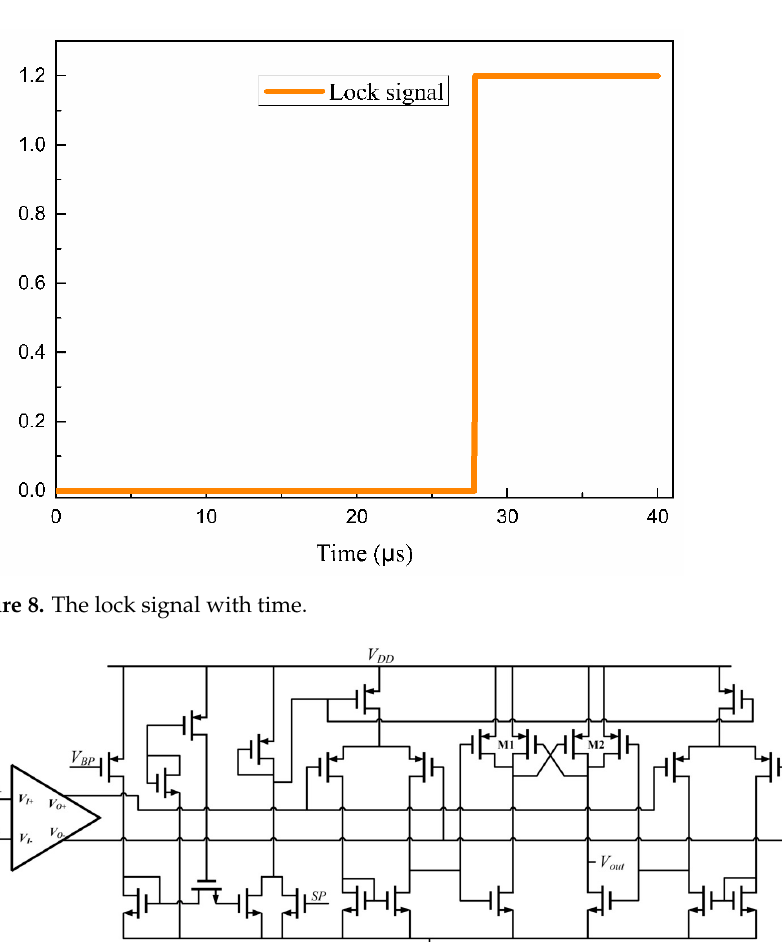
Figure 7. The SWB and V C1 levels with time.